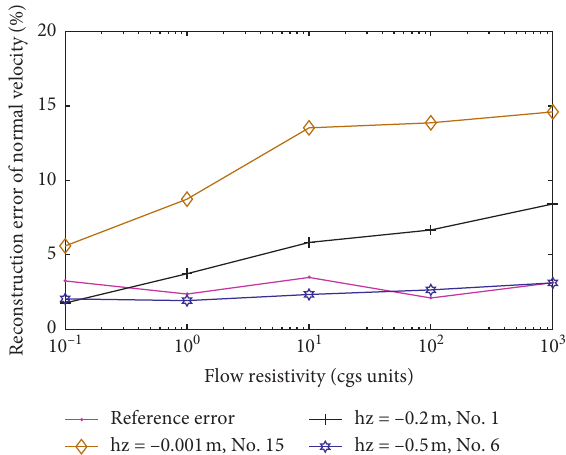
Figure 5: The reconstruction error of normal velocity versus the flow resistivity.